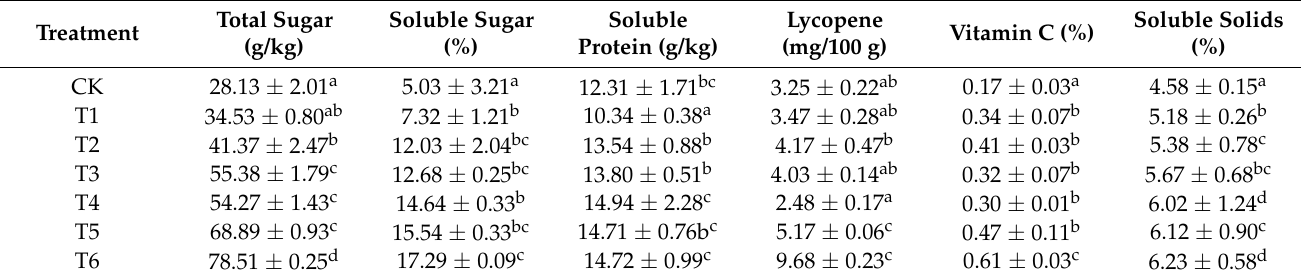
Table 2. Effect of different treatments on tomato